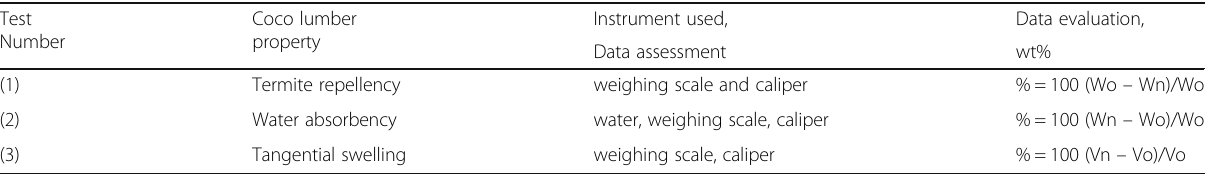
Table 2 Data assessment and evaluation of coco wood property Test Number